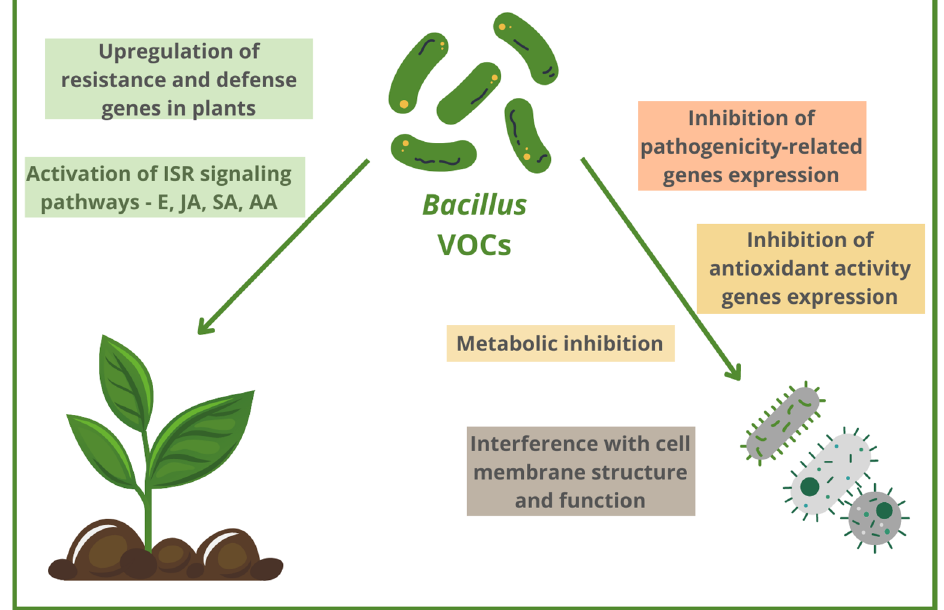
Figure 1. Mechanisms of antibacterial activity of Bacillus ‐ based VOCs (ISR—induced systemic resistance; E—ethylene; JA—jasmonic acid; SA—salycilic acid; AA—abscisic acid).